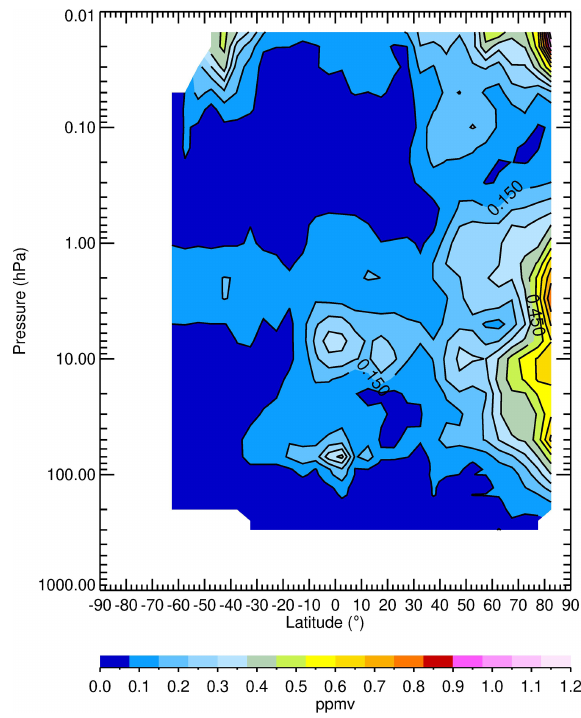
Figure 3. Zonal standard deviation about average (A+D) zonal mean ozone for January 1979. CI is